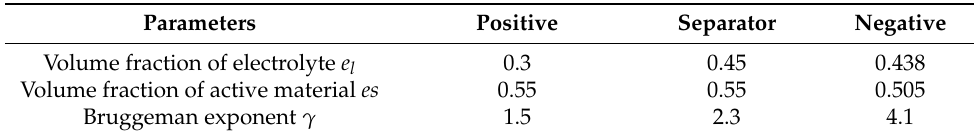
Table 3. Original volume fractions of the simulated battery